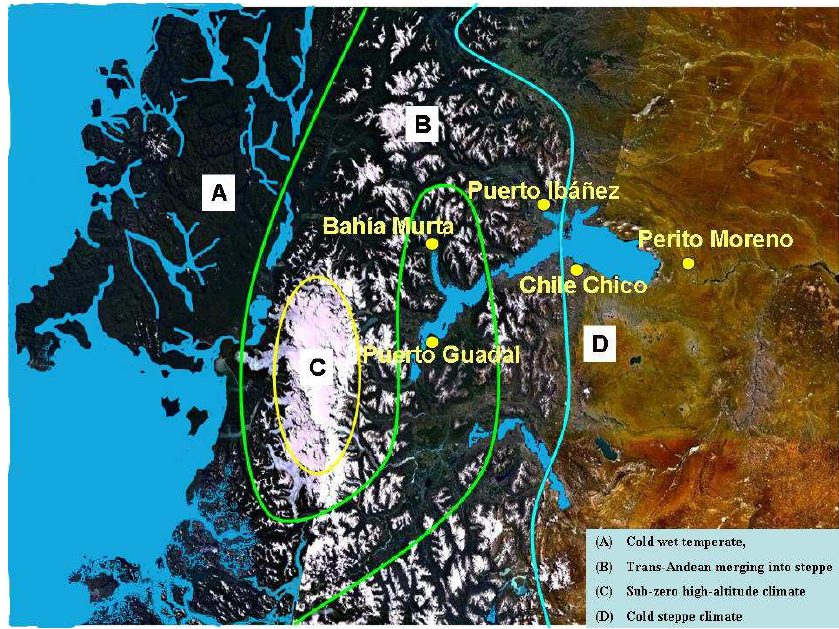
Fig. 1. Study site, showing the location of the in situ monitoring stations and the main climatic zones.